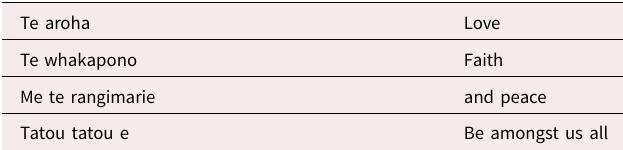
Table 4. Lyrics to the waiata , Te Aroha. Lyrist and date